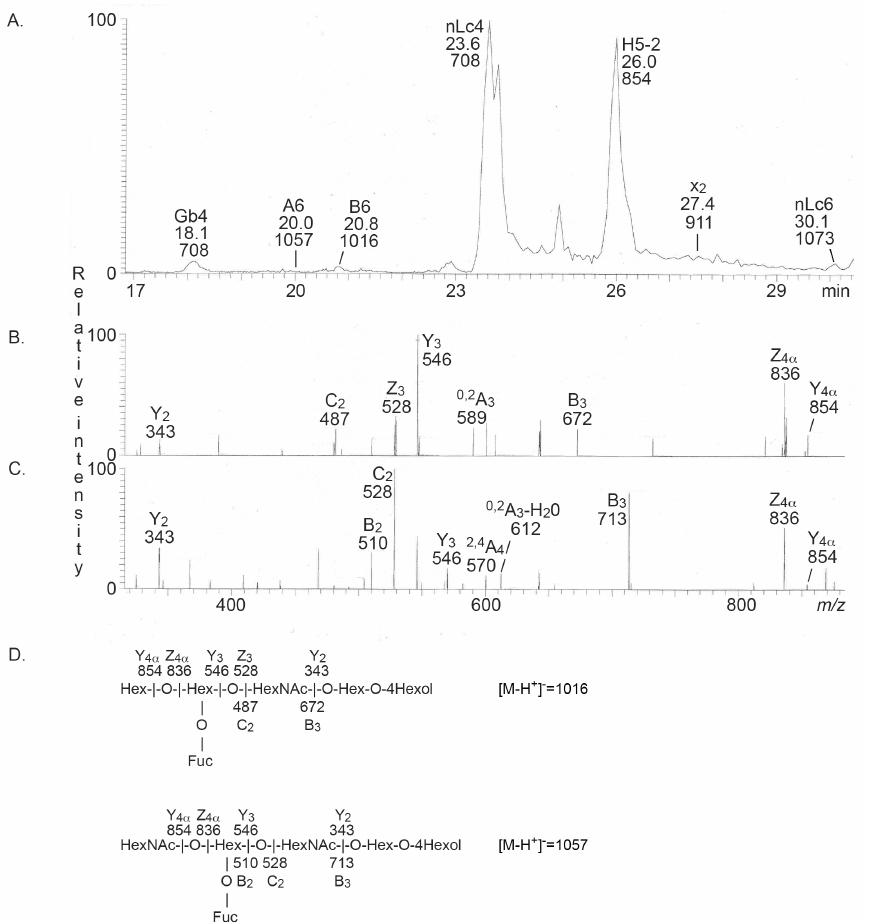
Figure 5. LC-ESI/MS of the reduced oligosaccharides obtained from the total non-acid glycosphin- golipid fraction from human parathyroid gland by hydrolysis with endoglycoceramidase II from Rhodococcus spp. ( A ) Base peak chromatogram from LC-ESI/MS of the reduced oligosaccharides obtained from human parathyroid gland. ( B ) MS 2 of the ion at m / z 1016 at retention time 20.8 min. The MS 2 spectrum had a C 2 fragment ion at m / z 487, and a B 3 ion at m / z 672, demonstrating a terminal Hex-(Fuc-)Hex-HexNAc sequence. A type 2 core chain was identified by the 0,2 A 3 ion at m / z 589. A terminal Hex was shown by the Y 4 α ion at m / z 854, and the Z 4 α ion at m / z 836, and there was also a Y 3 ion at m / z 546, and a Y 2 ion at m / z 343. Taken together, this demonstrated a blood group B type 2 hexasaccharide (Gal α 3(Fuc α 2)Gal β 4GlcNAc β 3Gal β 4Glc). ( C ) MS 2 of the ion at m / z 1057 at retention time 20.0 min. The MS 2 spectrum had a B 2 fragment ion at m / z 510, a C 2 fragment ion at m / z 528, and a B 3 ion at m / z 713, demonstrating a terminal HexNAc-(Fuc-)Hex-HexNAc sequence. The 0,2 A 3 fragment ion at m / z 713 showed that the internal HexNAc was substituted at C-4, i.e., a type 2 chain. There was also a Y 3 ion at m / z 546, a Y 2 ion at m / z 343, a Z 4 α ion at m / z 836, and a Y 4 α ion at m / z 854. Taken together, this demonstrated a blood group A type 2 hexasaccharide (GalNAc α 3(Fuc α 2)Gal β 4GlcNAc β 3Gal β 4Glc). ( D ) Interpretation formulas showing the deduced oligosaccharide sequence. The oligosaccharides identified in the chromatograms were: Gb4, GalNAc β 3Gal α 4Gal β 4Glc; A6-2, GalNac α 3(Fuc α 2)Gal β 4GlcNAc β 3Gal β Glc; B6-2, Gal α 3(Fuc α 2)Gal β 4GlcNAc β 3Gal β Glc; nLc4, Gal β 4GlcNAc β 3Gal β 4Glc; H5- 2, Fuc α 2Gal β 4GlcNAc β 3Gal β 4Glc; x 2 , GalNAc β 3Gal β 4GlcNAc β 3Gal β 4Glc; nLc6, Gal β 4GlcNAc β 3Gal β 4GlcNAc β 3Gal β